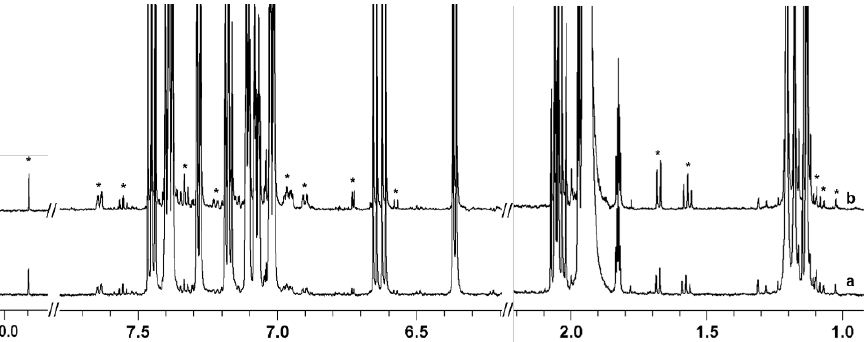
Figure 4. 1 H NMR (600 MHz, 300 K) spectra of a -DLM (9.2 mM) recorded after 48 h from preparation and kept at room temperature; ( a ) solution A and ( b ) solution B. (*) indicates signals belonging to new species.